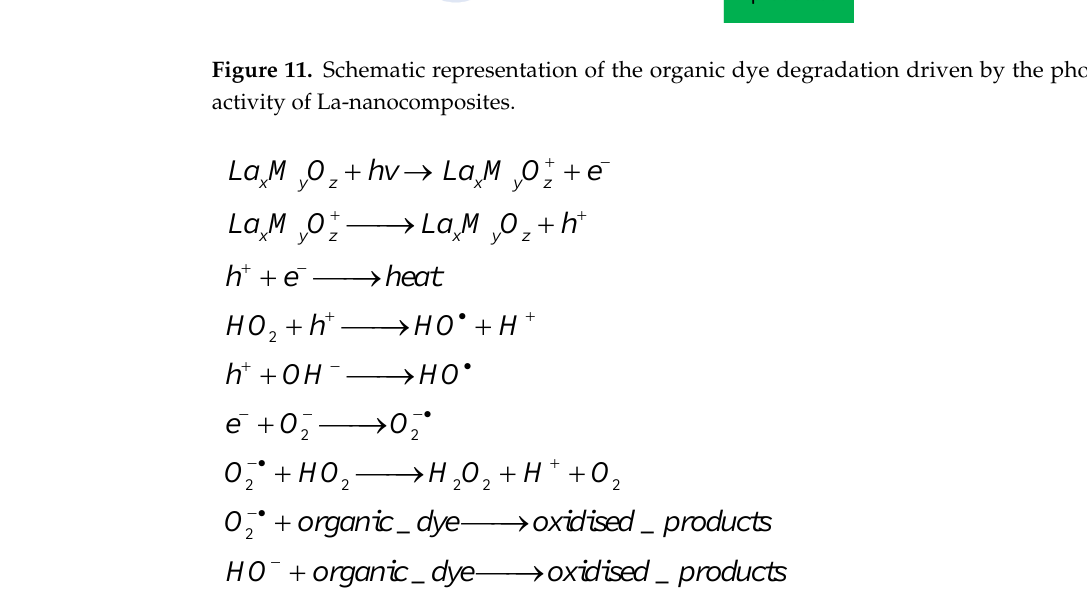
Scheme 1. Reaction equations for degradation of MB and o-TB dyes on